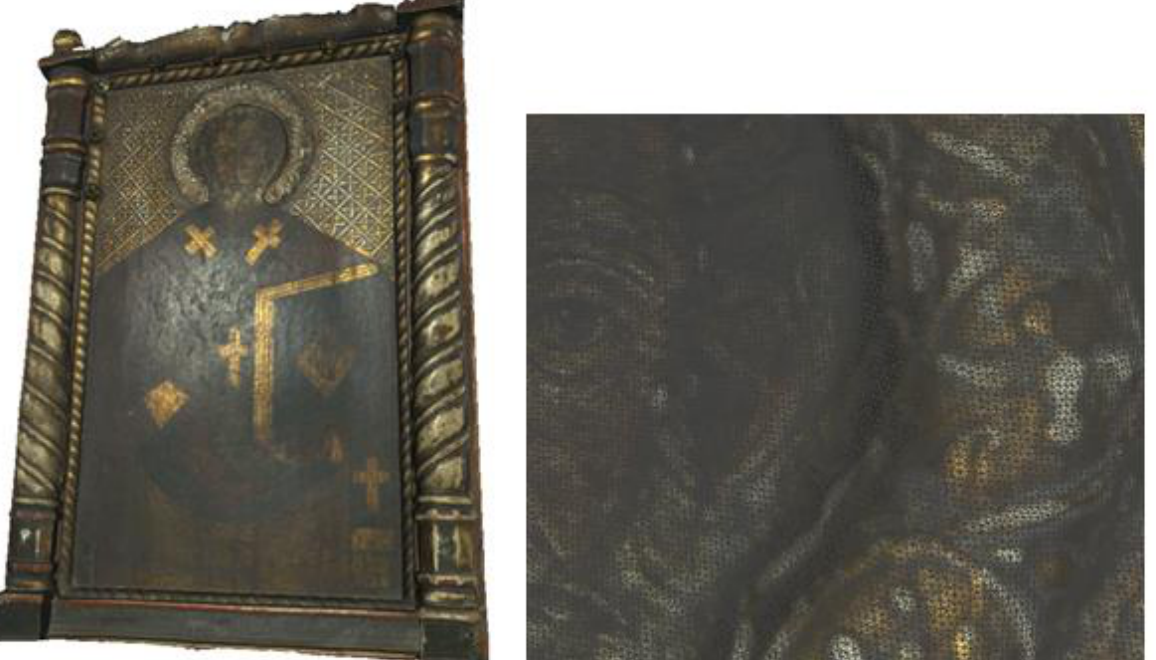
Figure 9. 3D base model of the “Icon of Saint Nicholas of Myra”: overview (on the left ) and mesh visible (on the right ).